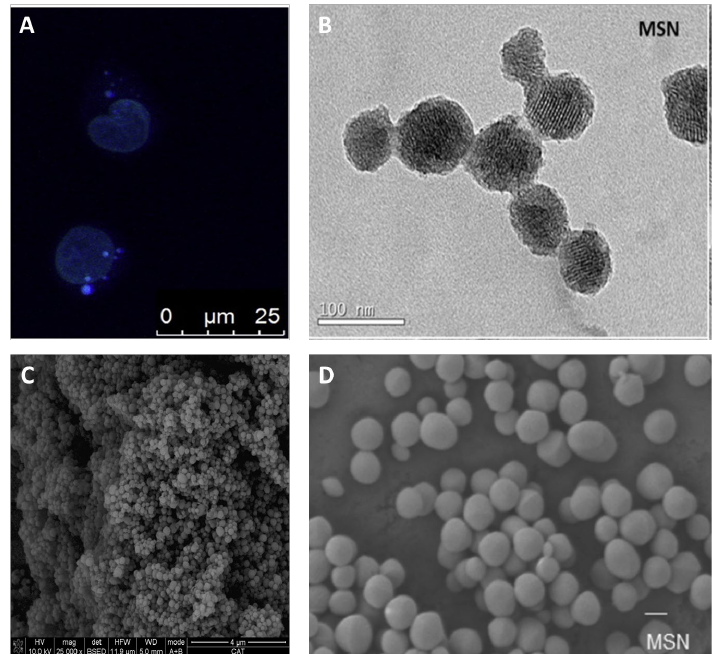
Figure 11. ( A ) Microscopy images of the internalization of SBA-15 in HL-60 cells, dark blue dots are due to accumulation of nanostructured material inside the cells [97], ( B ) TEM of MSN [98], ( C ) SEM of MSN [99] and ( D ) SEM of MSN, scale bar 200 nm [100]. Reproduced with permission. Copyright © Elsevier ( A ), © Royal Society of Chemistry ( B ), and © American Chemical Society ( C , D ).